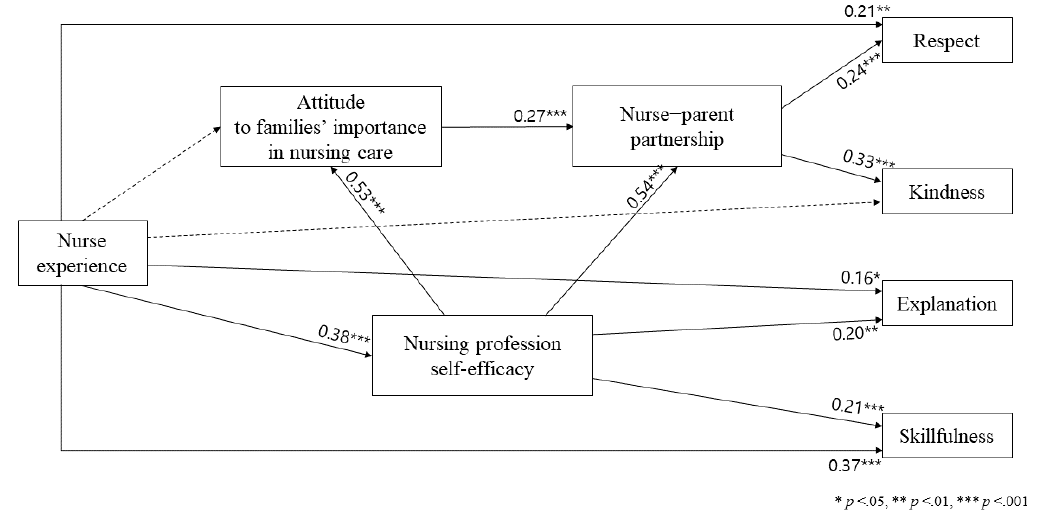
Figure 3. Modified model of factors influencing quality of nursing care in pediatric units.